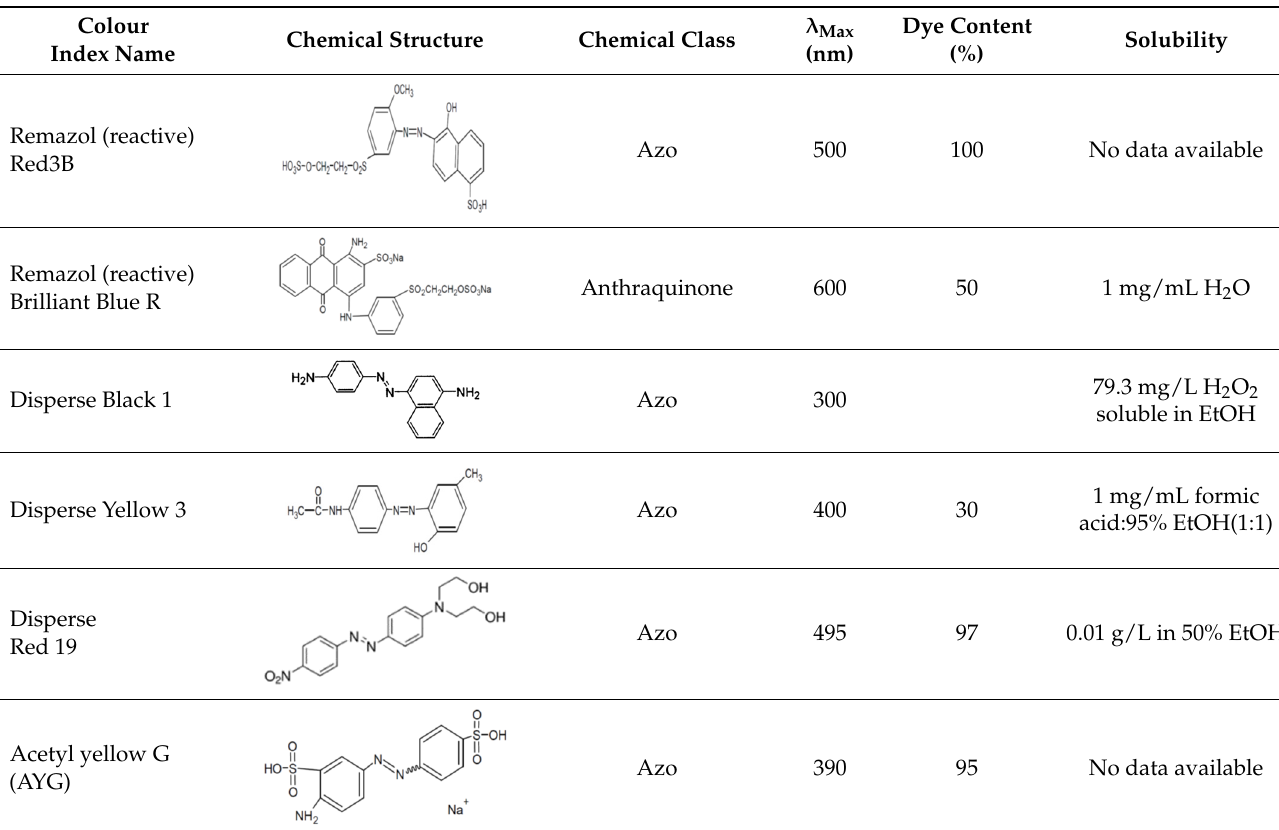
Table 1. Characteristics of the dyes used in the present study.